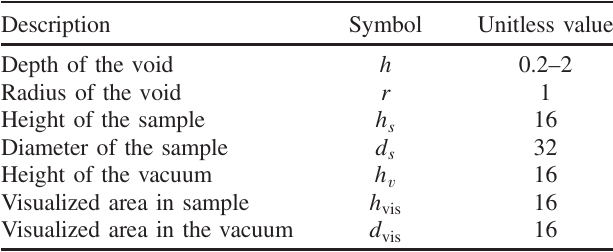
TABLE II. Geometrical